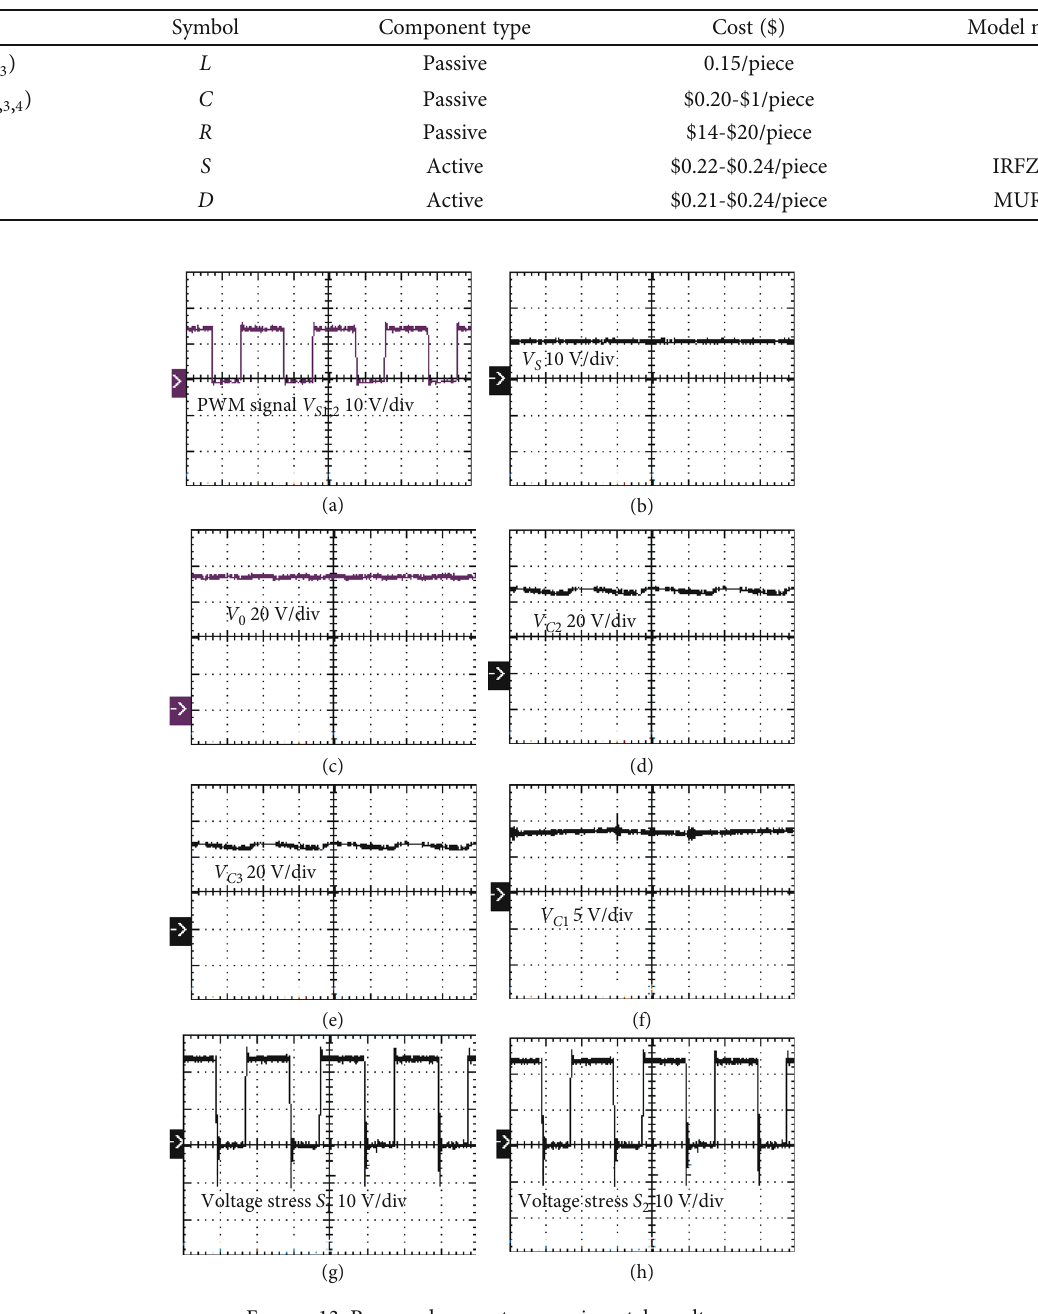
Figure 13: Proposed converter experimental